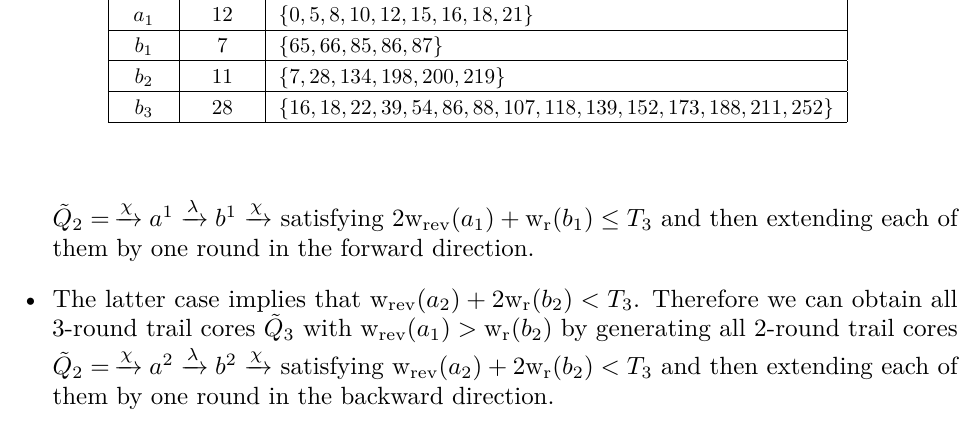
Table 4: A canonical 4-round differential trail core with the minimum weight.